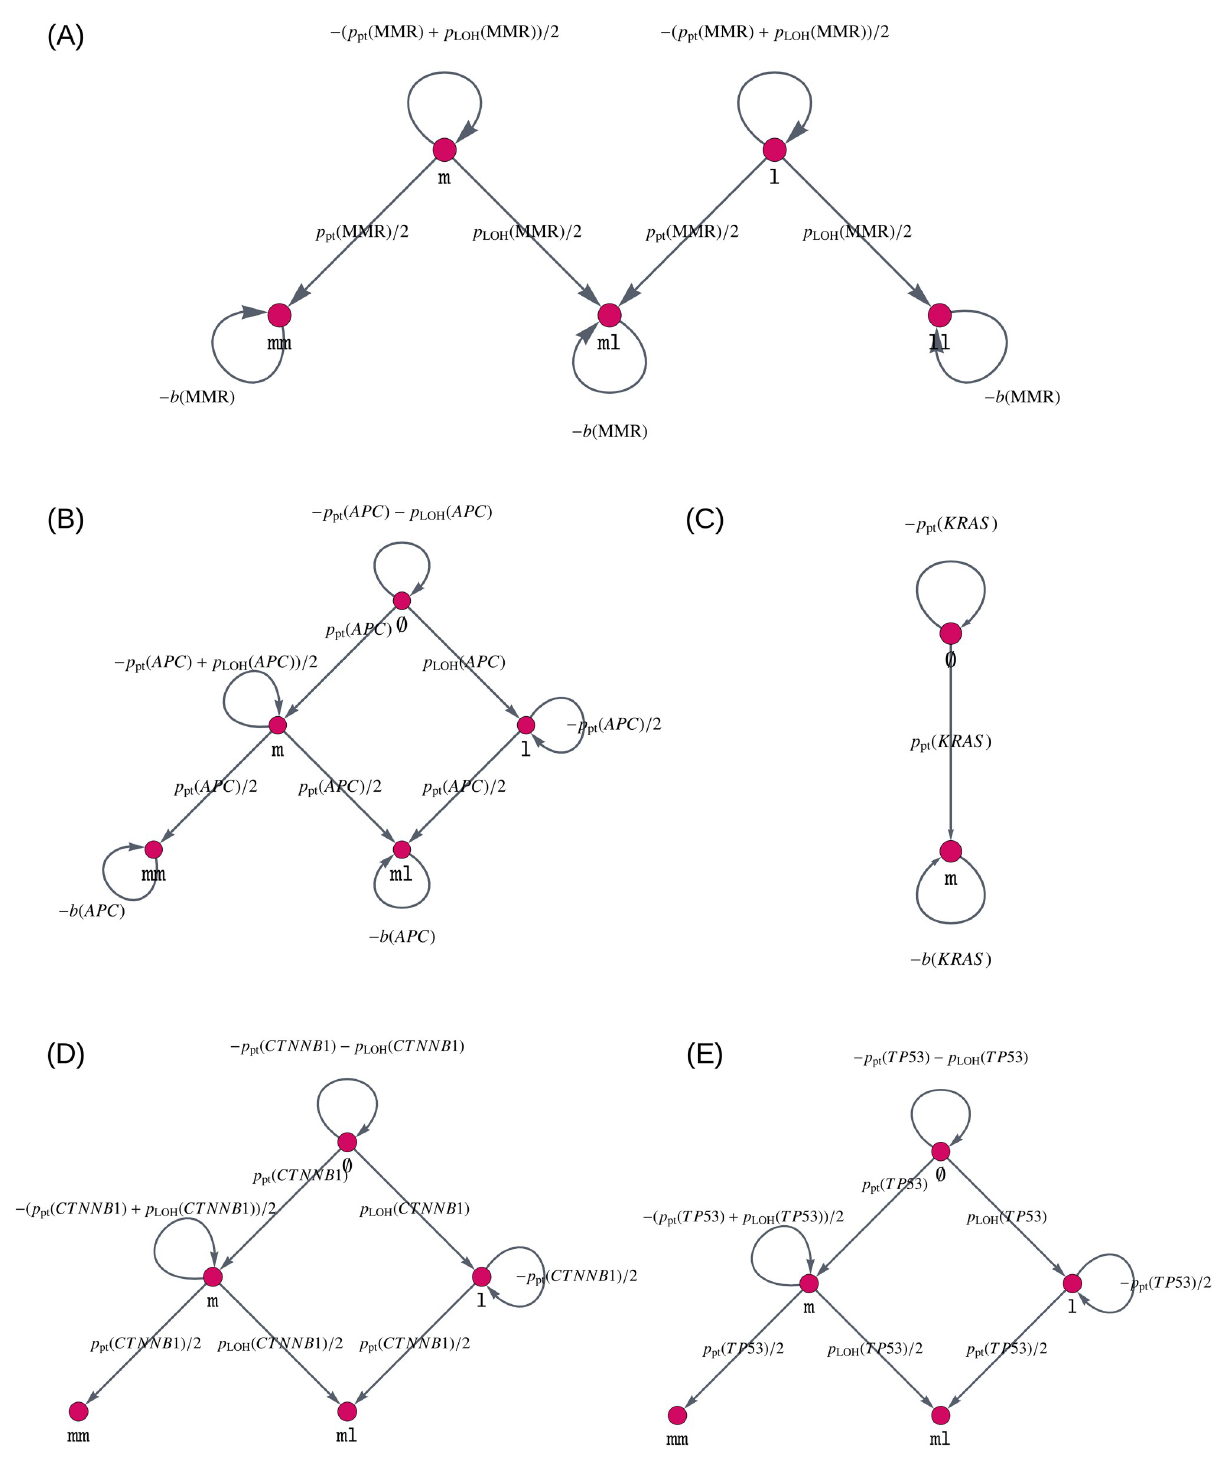
Fig 2. Gene mutation graphs for independent mutational processes. These graphs represent the possible mutation status, i.e., which mutations the alleles of the gene can have accumulated, as vertices ; , m , l , mm , ll and ml . They are given for (A) MMR gene mutations, (B) APC mutations, (C) KRAS mutations, (D) CTNNB1 mutations, and (E) TP53 mutations. The edges connecting different vertices represent mutations, whereas self-loops, i.e., edges that connect a vertex with itself, describe no mutation occurring at the current point in time. The edges are labeled by the amount of change which happens at each point in time. Note that in the colon, biallelic mutations of CTNNB1 seem to be required to mediate an oncogenic driver effect [61, 62], leading to a gene mutation graph similar to that of APC and TP53 .